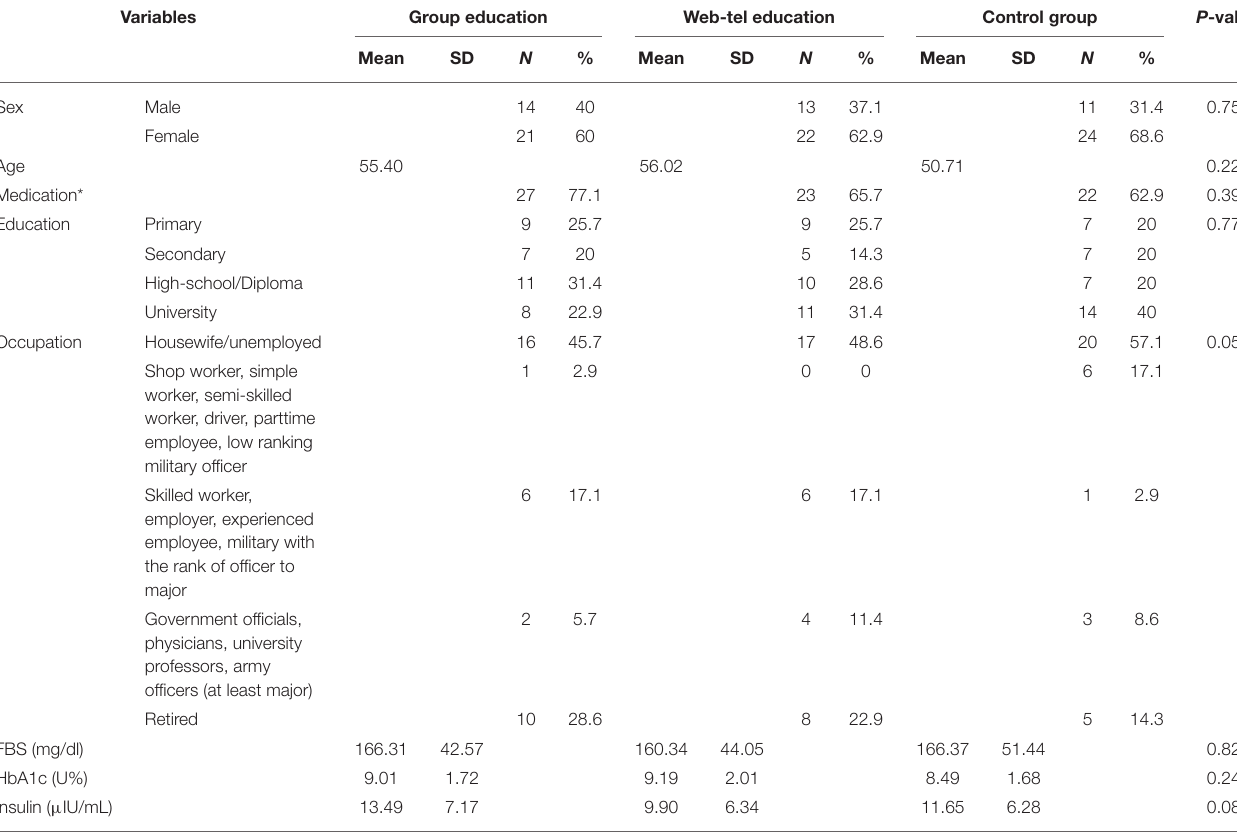
TABLE 1 | Baseline characteristics of the participants.